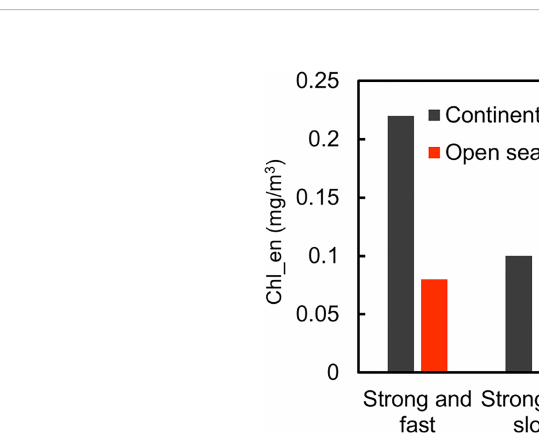
FIGURE 7 Average Chl_en induced by four groups of TCs in the continental shelf (black bar) and open sea (red bar) regions.